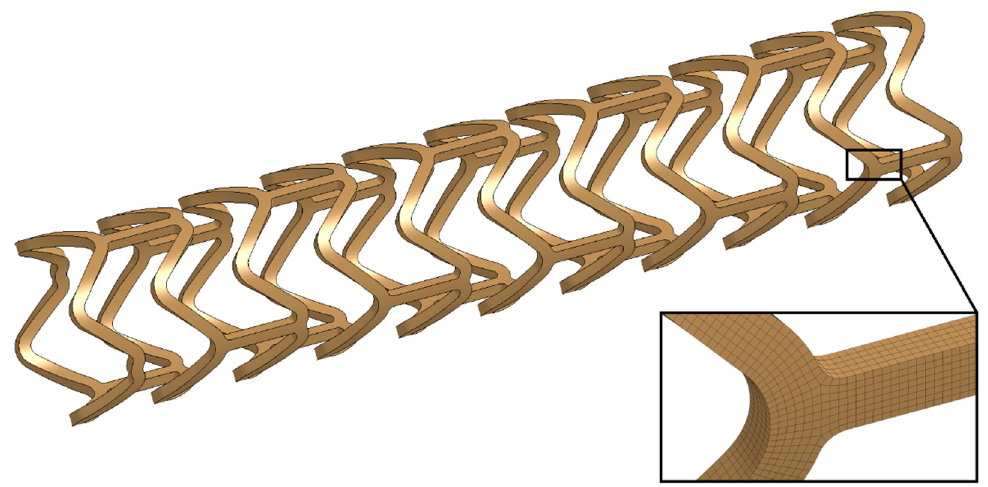
Figure 5. Model geometry for validation analyses of the PLGA bioresorbable polymer constitutive model.